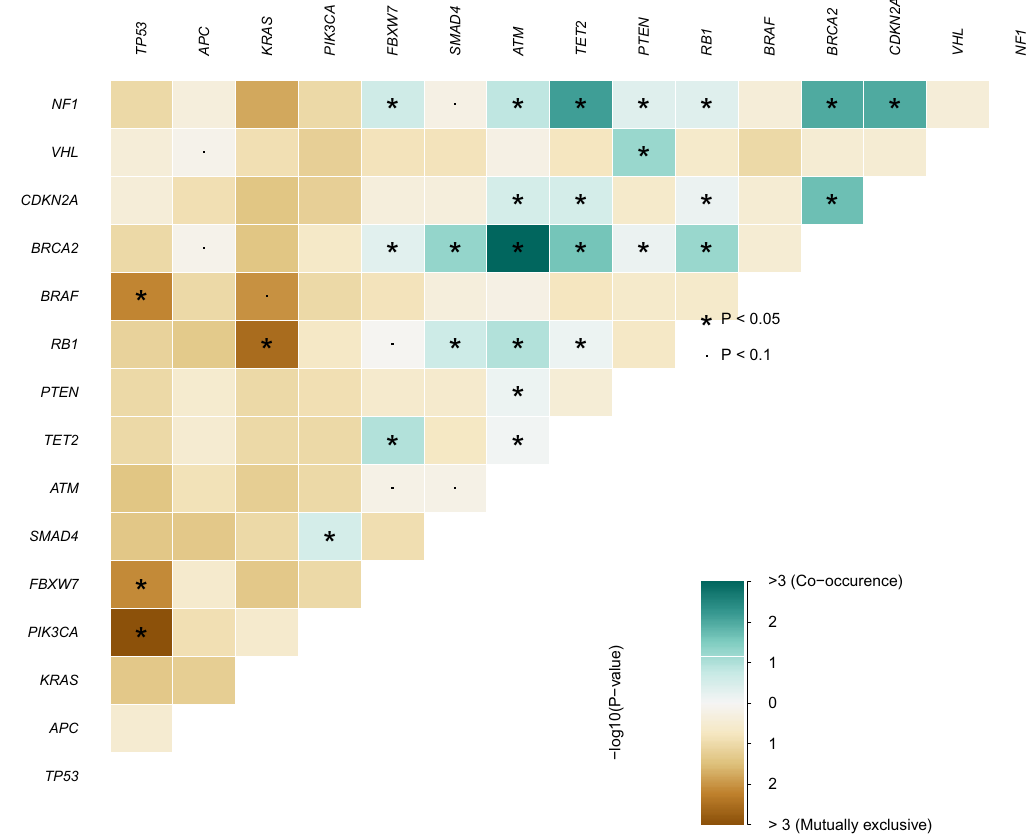
Figure 3. Mutually exclusive and co-occurring gene pairs in our dataset presented in a triangular matrix. Bluish green indicates a tendency toward co-occurrence, whereas brown indicates a tendency toward mutually